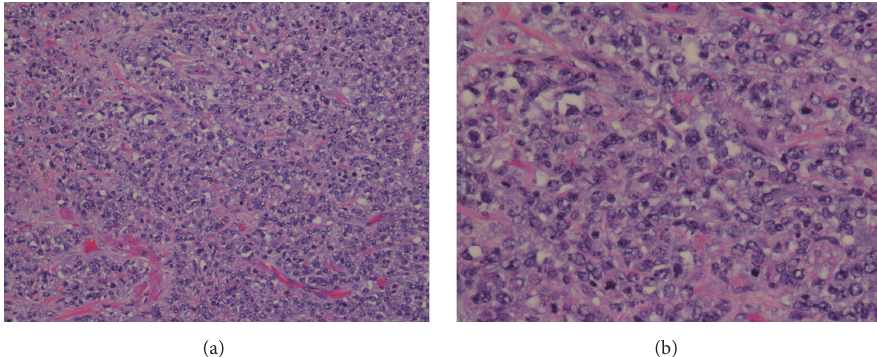
Figure 1: (a) Medium and (b) high power images display a neoplastic proliferation of large, atypical cells with vesicular chromatin and prominent nucleoli. (Hematoxylin-eosin stain; (a) 20x magnification and (b) 40x